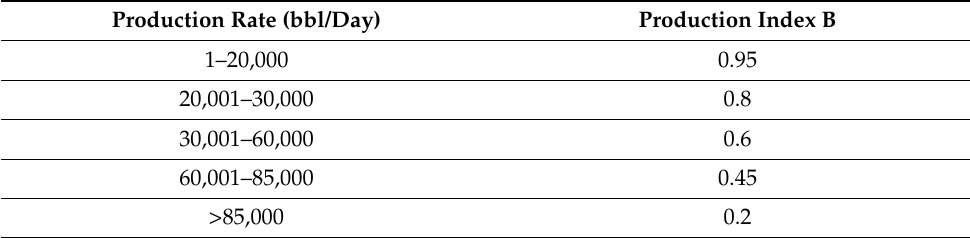
Table 3. Initial settings of Production Rate and Production Index, B factor.